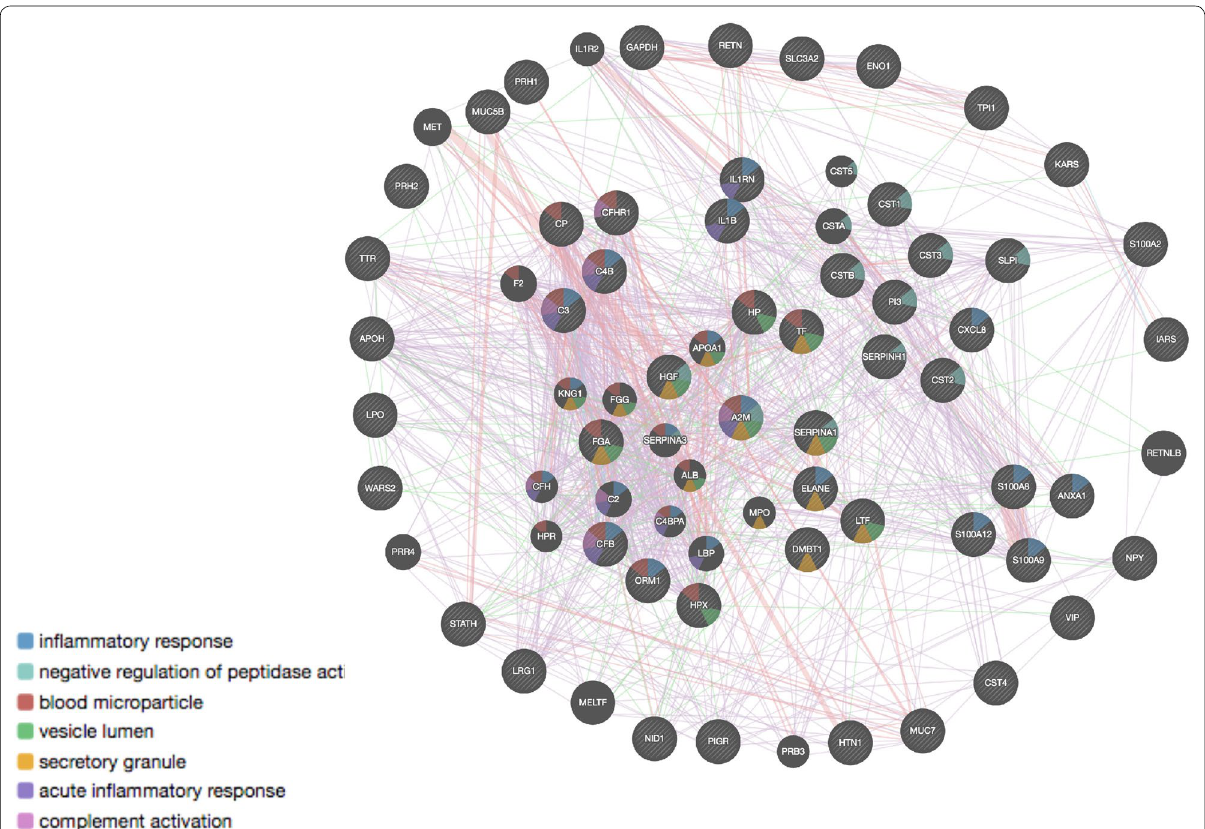
Fig. 1 Pathway analysis using GENEMANIA [90]. The seven most relevant pathways are shown (nodes are colored accordingly). The network was generated taking into account the co-expression, physical interactions, pathway and genetic interaction networks (edges). Protein entries used for the network are given as Additional file